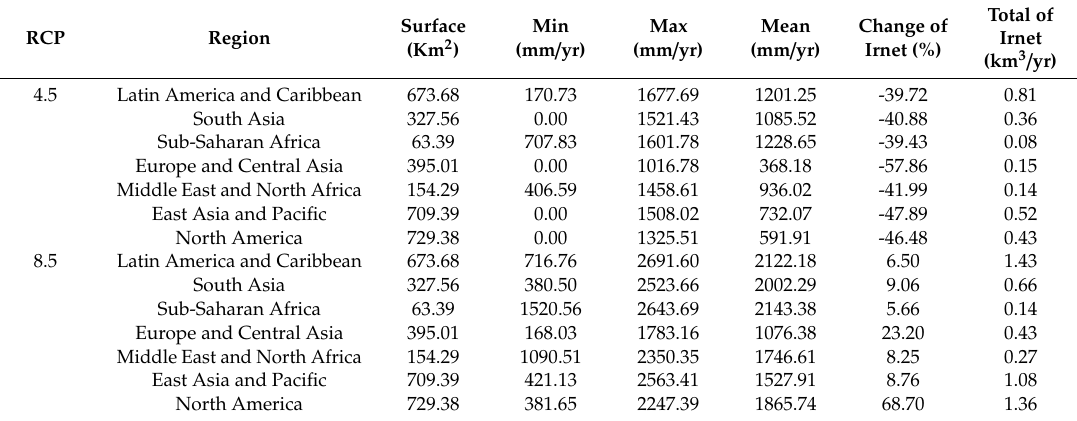
Table 6. NCAR regional net irrigation water